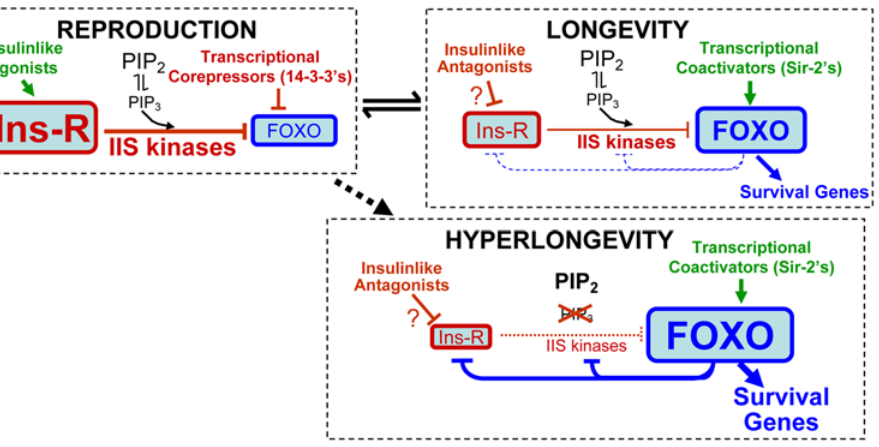
Figure 6. Model of the IIS ‘‘molecular switch.’’ Three proposed system states are depicted, reflecting the balance between kinase signaling and transcriptional feedback suppression: reproductive mode , in which kinase signaling predominates, activated via the insulin/IGF-1 receptor (DAF-2, here labeled Ins-R); longevity mode , wherein FOXO (DAF-16) prevails and suppresses kinase transcription; and hyperlongevity mode —in which switching between the first two modes is blocked, thus strongly favoring survival but with no possibility of resuming reproduction. State transitions are normally triggered by signaling modulators (e.g., insulin-like peptides [12] or SIR-2/14-3-3 complex [77]), to which age-1(mg44) -F2 mutants (‘‘hyperlongevity’’ state) cannot